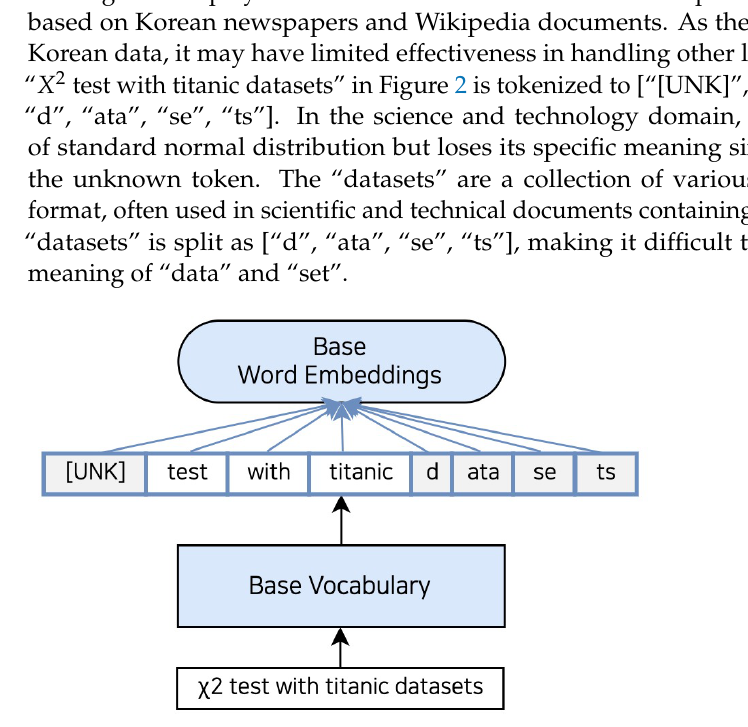
Figure 2. Examples using the tokenizer of the pre-trained language models. The input sentence is tokenized as vocabulary learned in the pre-trained and uses the pre-trained language models embeddings. For example, when you tokenize the “ X 2 test with titanic datasets” using a base tokenizer, x 2 is a token to the “[UNK]” token. In addition, “Datasets” is divided into “D”, “ata”, “se”,